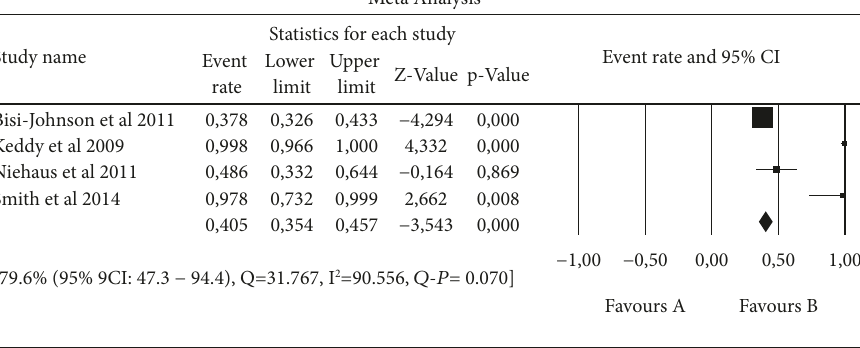
Figure 3: Forest plot showing the pooled estimates of Salmonella serovars from human. The squares demonstrate the individual point estimate. The diamond at the base indicates the pooled estimates from the overall studies.